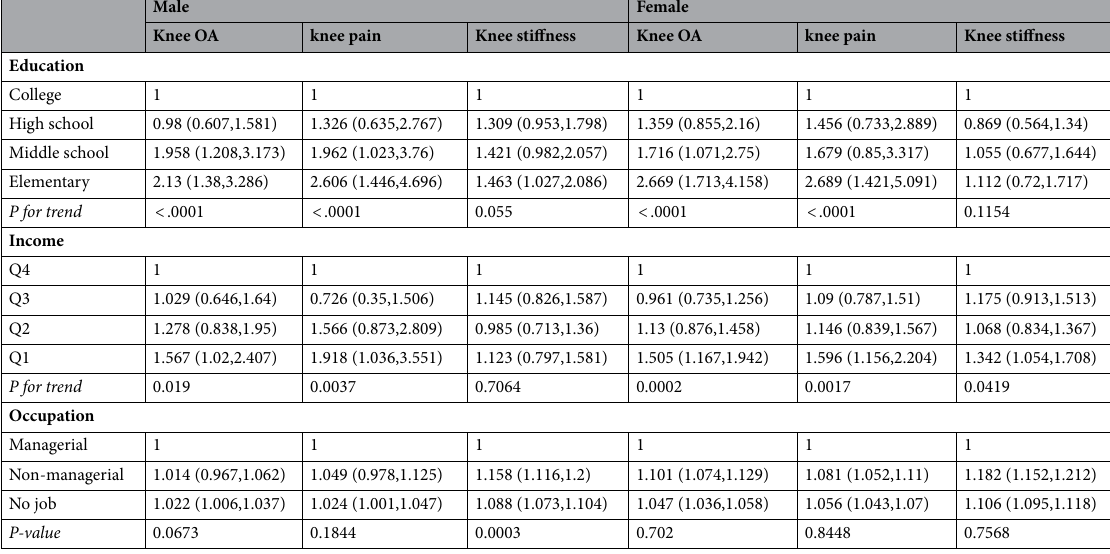
Table 3. Odds ratios of radiographic knee OA and knee symptoms by component of SES. Adjusted for age, BMI, education, and income or occupation. OA, osteoarthritis; SES, socioeconomic